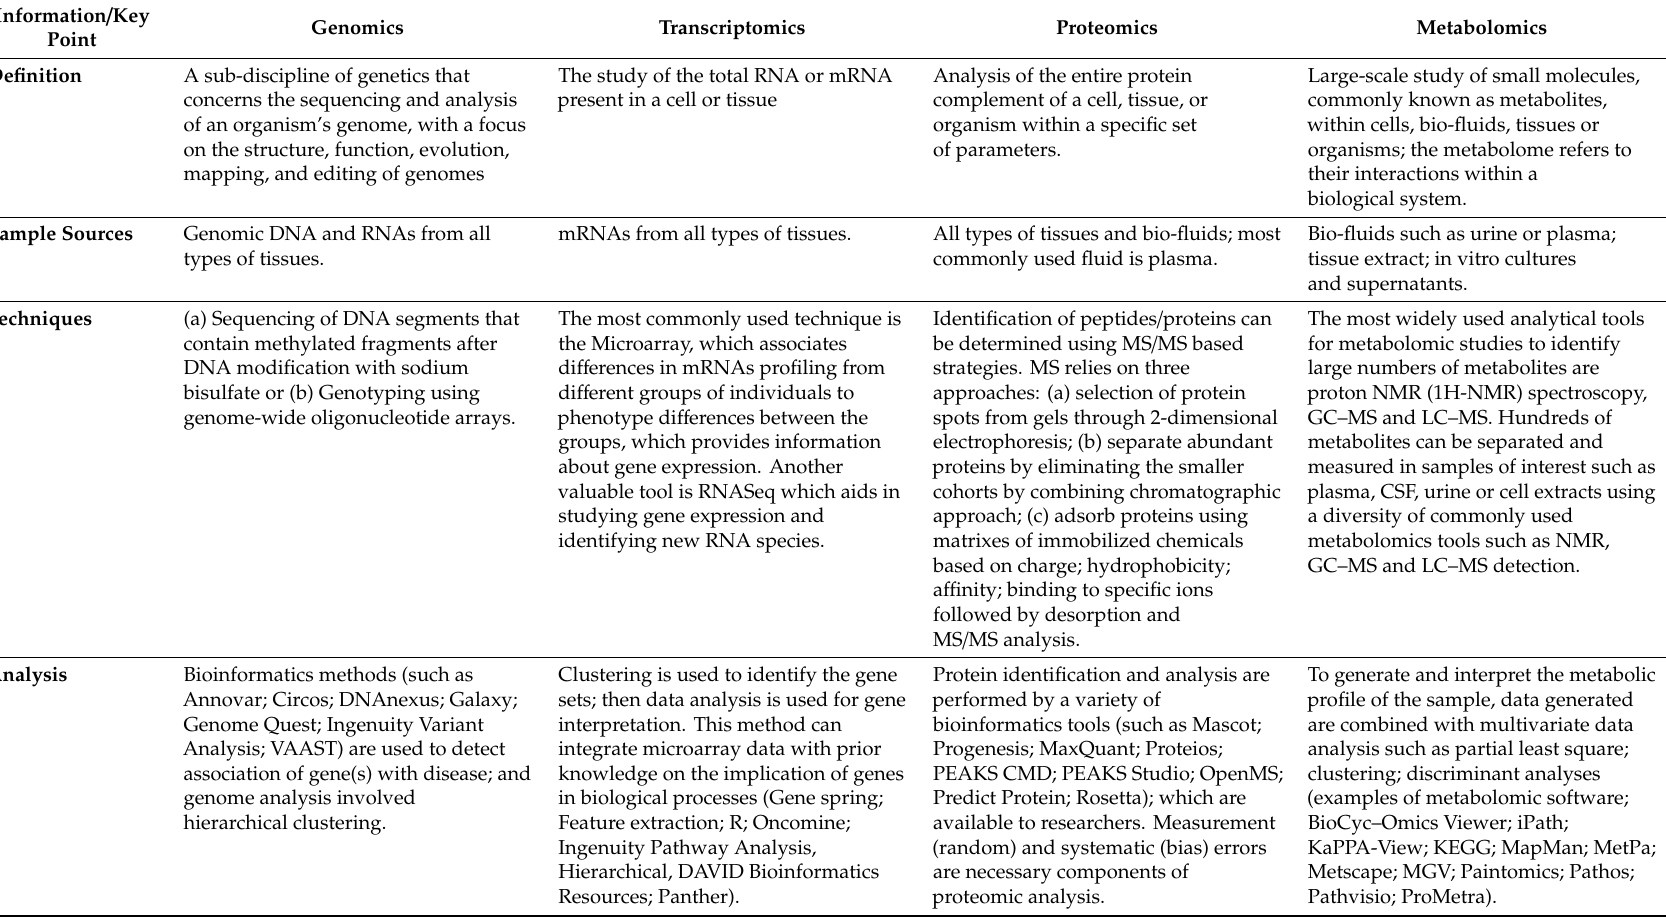
Table A2. Omics applications used in personalized